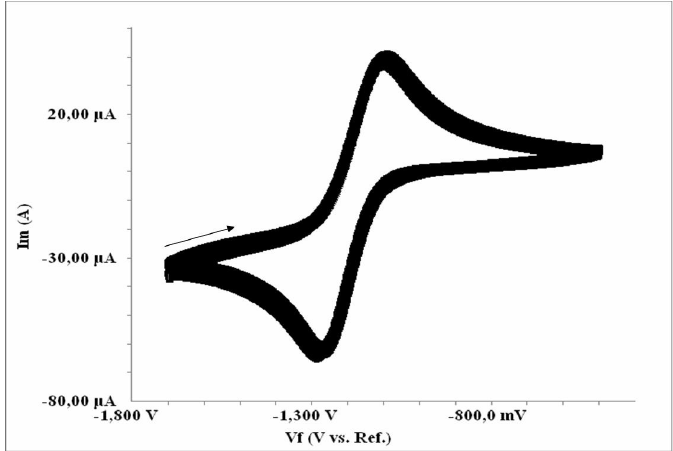
Figure 1. Cyclic voltammograms of procaine on bare glassy carbon electrode surface, -1,7/- 0,5 V potential range 100 mV s -1 scanning rate having 50 cycle